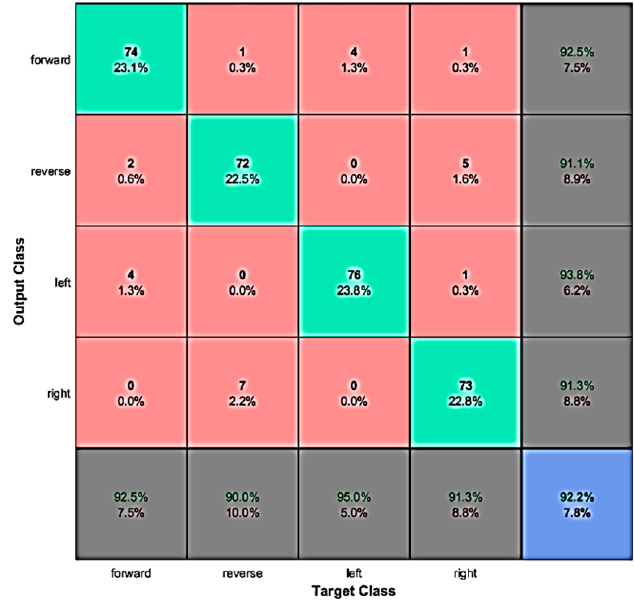
Figure 12. Confusion matrix for ages 20 to 28.